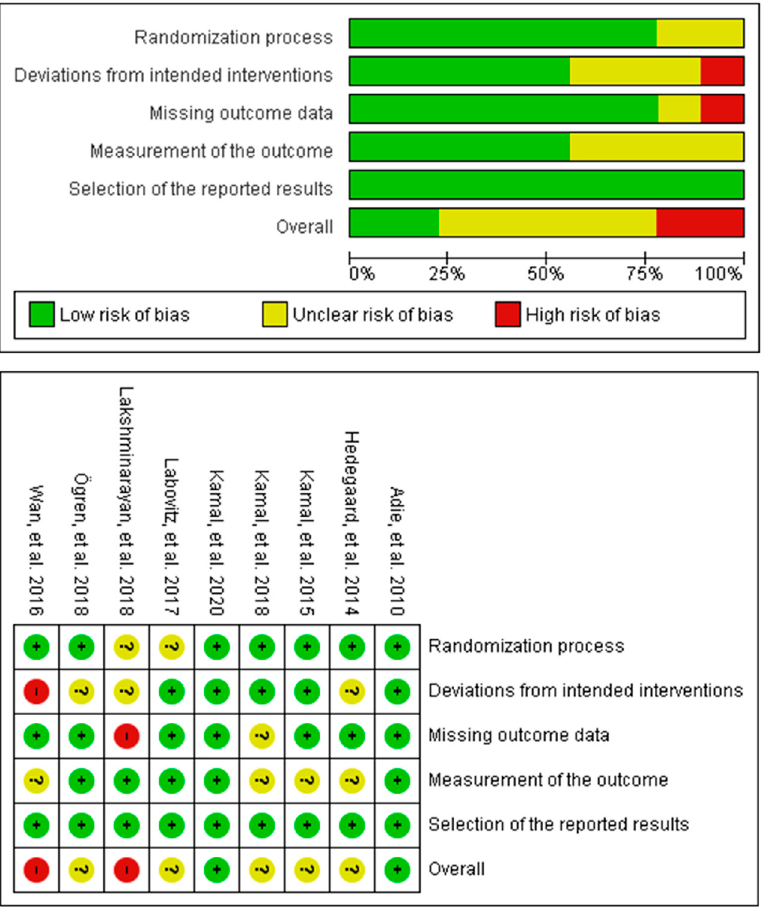
Figure 2. Summary of the overall risk of bias assessment in the individual RCT studies. The cluster RCT was omitted due to the absence of an extra domain (recruitment process).